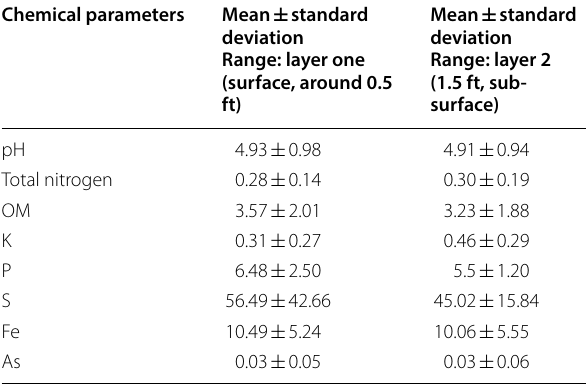
Table 2 Mean and standard deviation of soil samples Chemical parameters